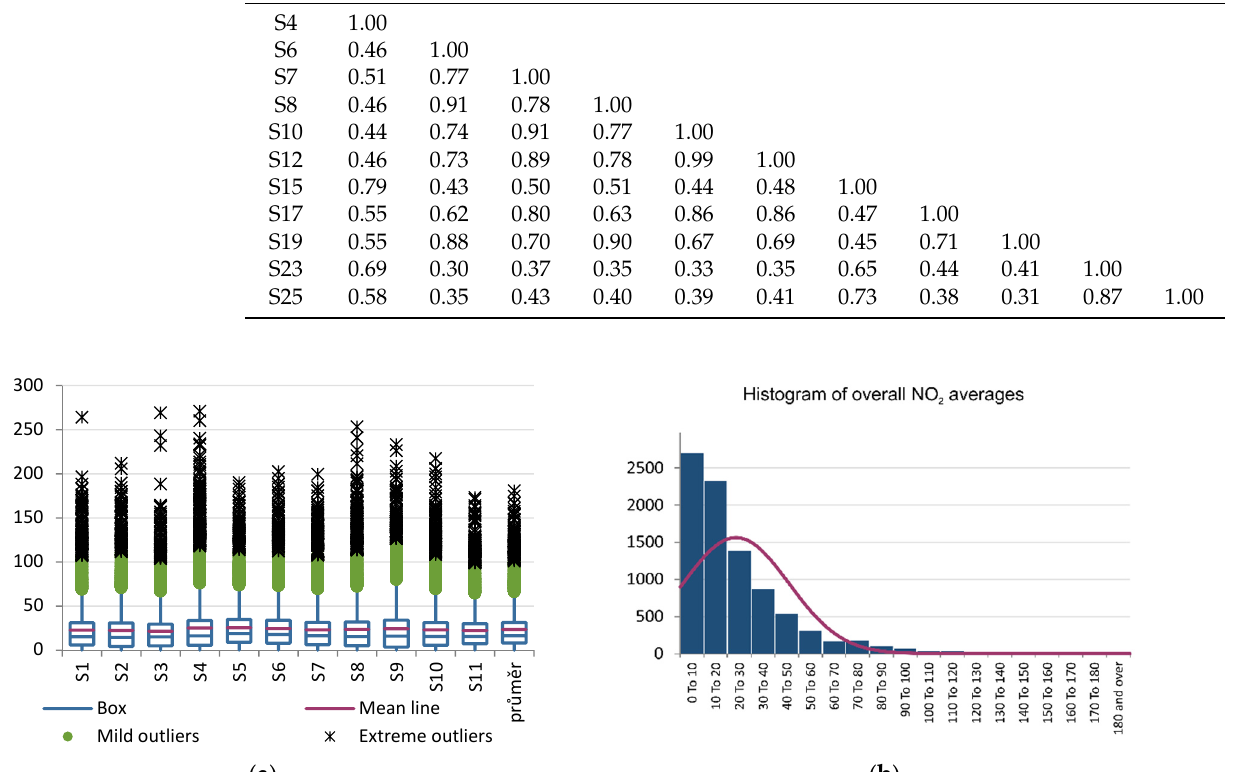
0.28 Figure 7. Regression plot of reference (AC32) vs. sensor (S25) datasets. -2002040 60 80 100 0